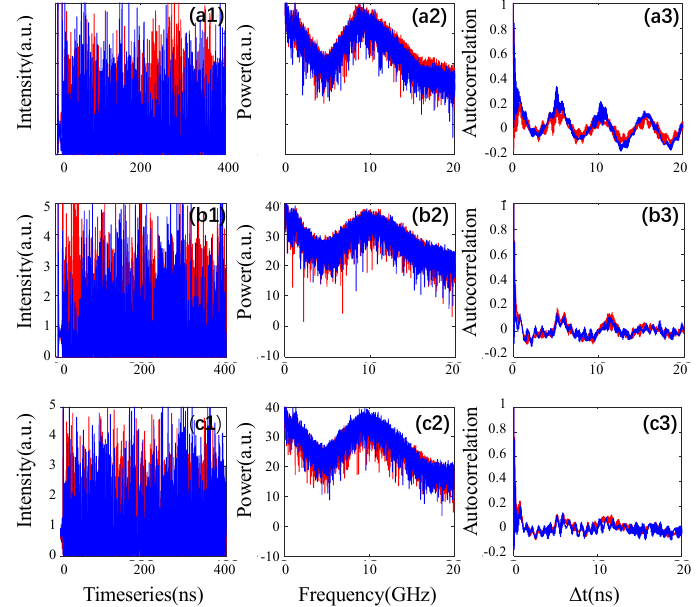
Figure 4. The timeseries ( a1 – c1 ), power spectrum ( a2 – c2 ) and ACF ( a3 – c3 ) of the SSRL. The blue line denotes CW, and the red line denotes CCW. The currents of MSRL and SSRL are µ = 2.5. The parameters are set as: ∆ f = 10 GHz, k inj = 35 ns − 1 . First row: α = 3.5, second: α = 5, third: α =